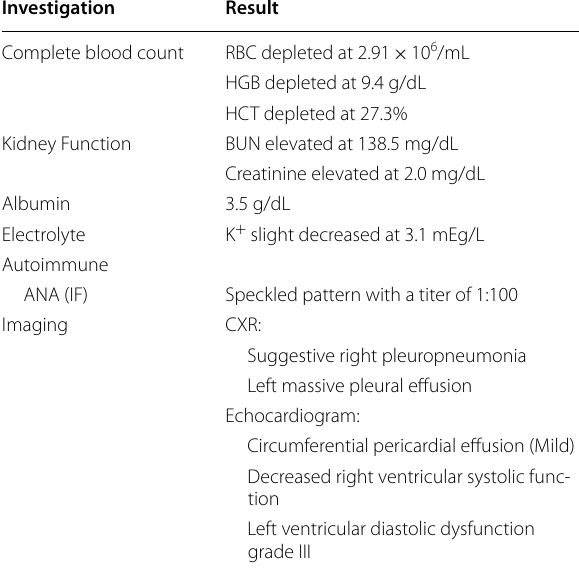
Table 1 Summary of